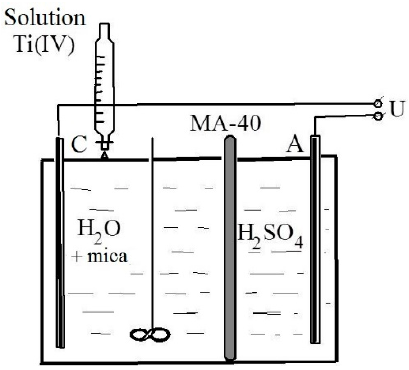
Figure 5. Electrodialysis installation.